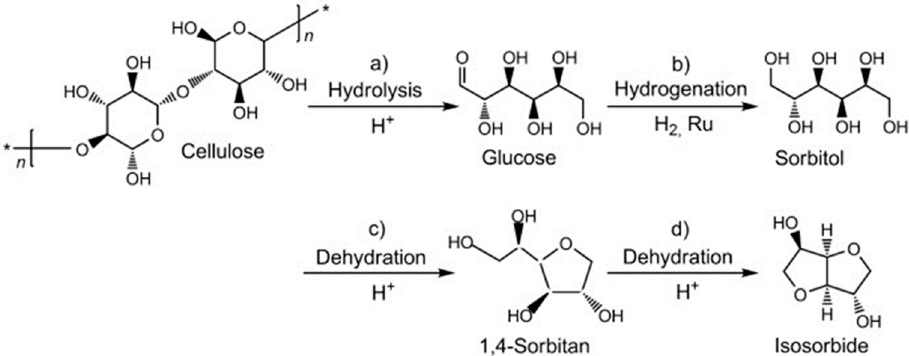
Figure 5. Steps for converting cellulose into isosorbide. Reproduced with permission from ref. [99] Copyright © 2013 WILEY-VCH Verlag GmbH & Co.